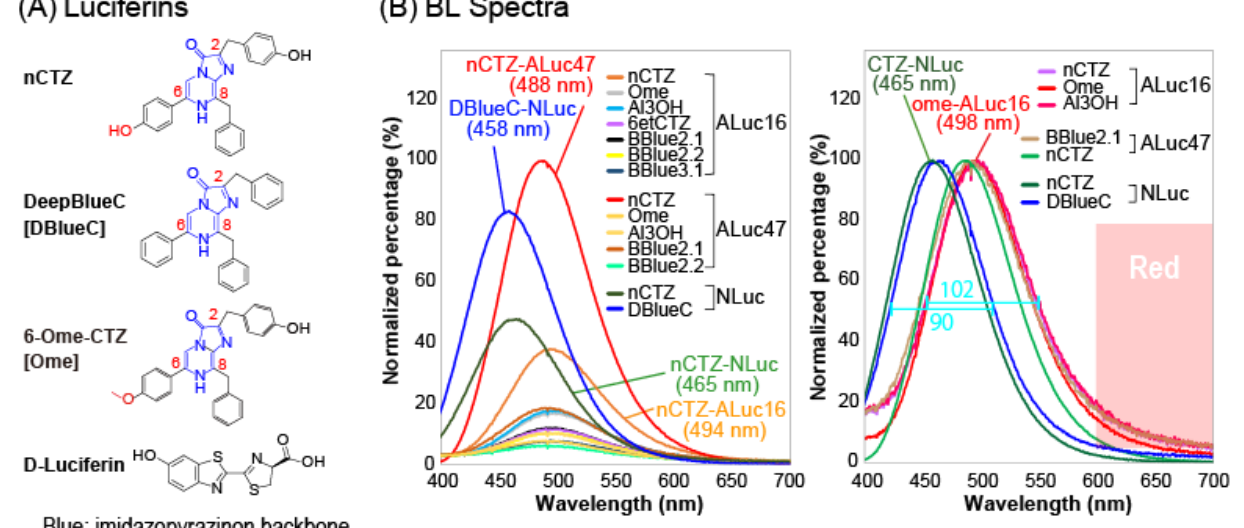
Figure 1. ( A ) Chemical structures of conventional or newly synthesized CTZ derivatives: nCTZ, native coelenterazine; DBlueC, DeepBlueC; Ome, 6-ome-CTZ. They commonly share an imidazopy- razinone backbone that is highlighted in blue. ( B ) Relative and normalized BL spectra of selected CTZ derivatives with marine luciferases, ALuc16, ALuc47, and NanoLuc (NLuc). The representative full width at half maximum (FWHM) values were annotated with cyan color.